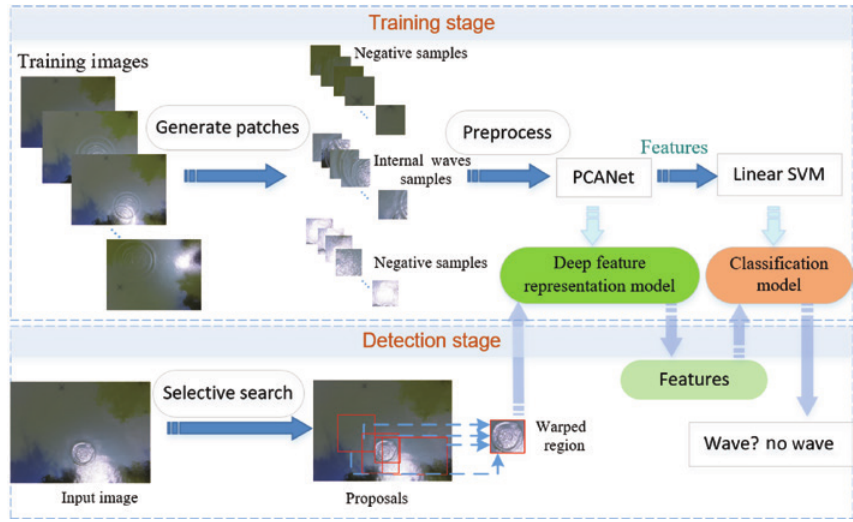
Figure 1: The flow chart of internal waves detection framework based on